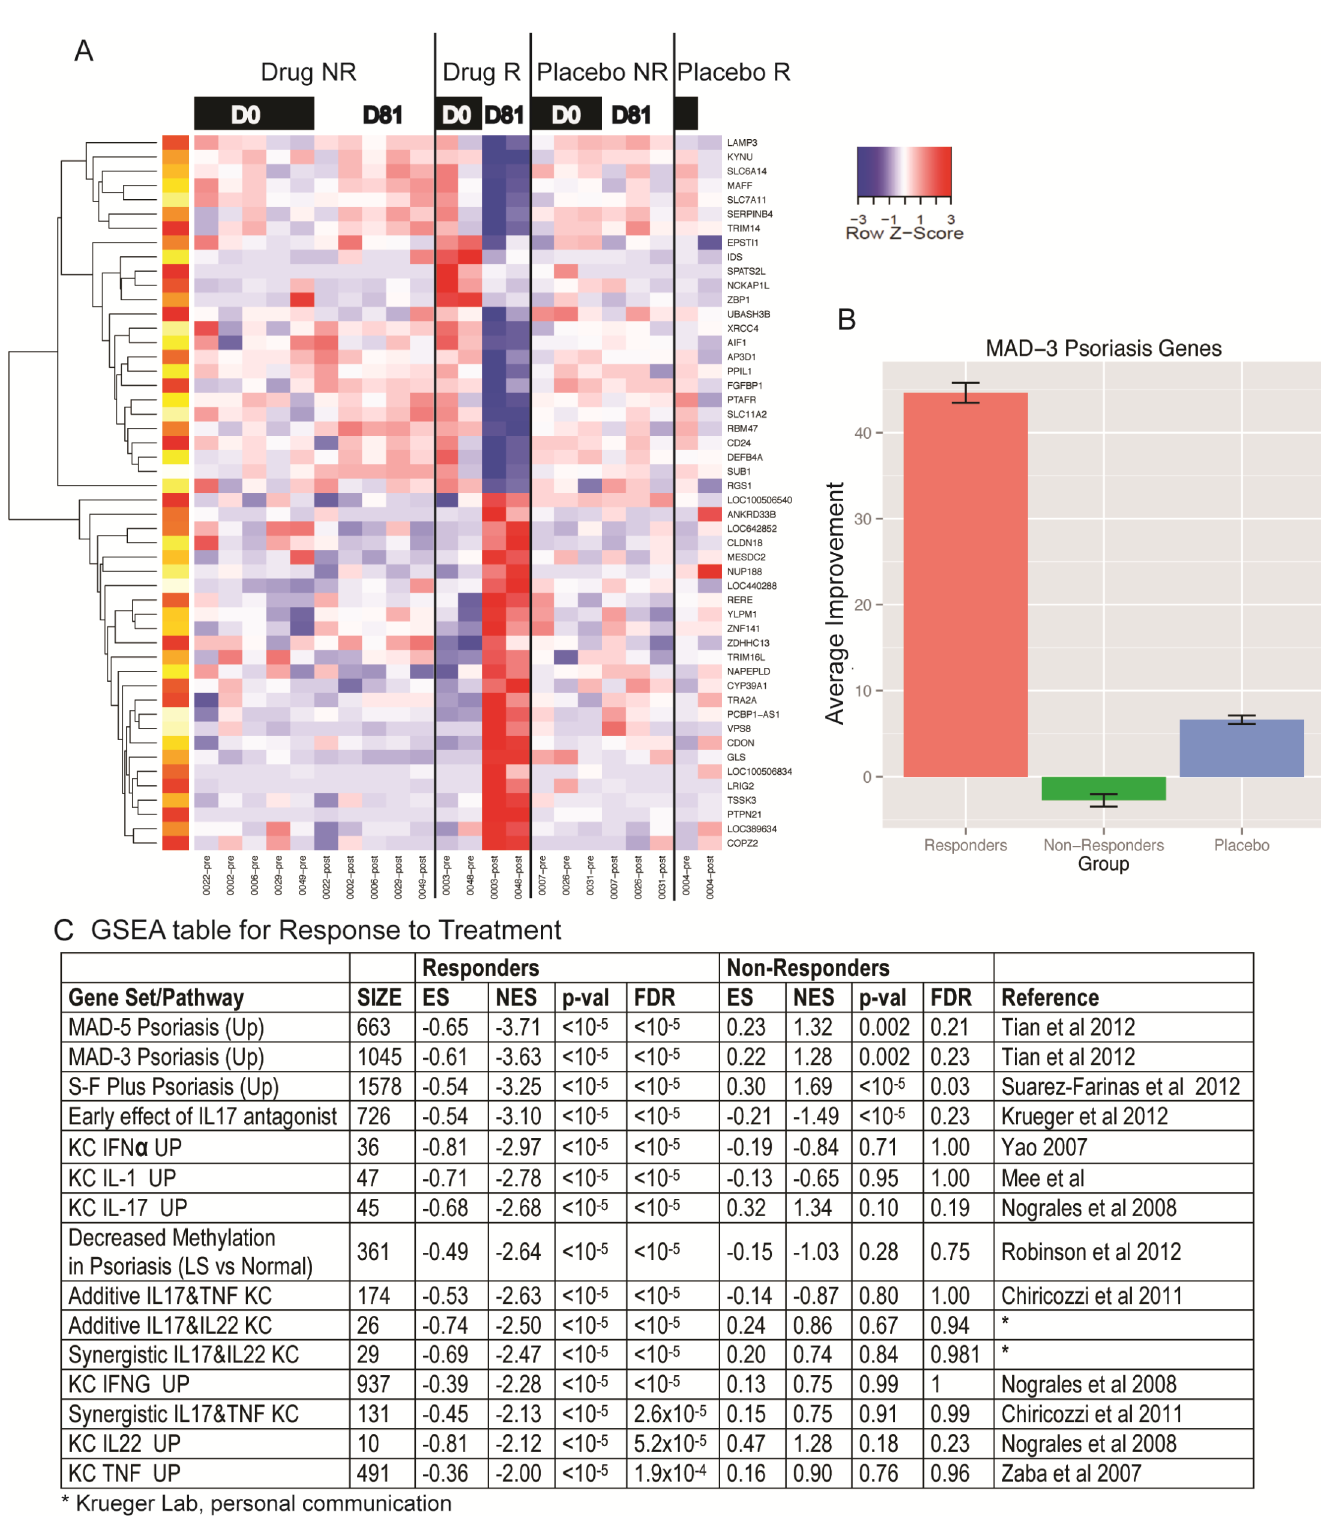
PLOS ONE | DOI:10.1371/journal.pone.0142081 November 10,